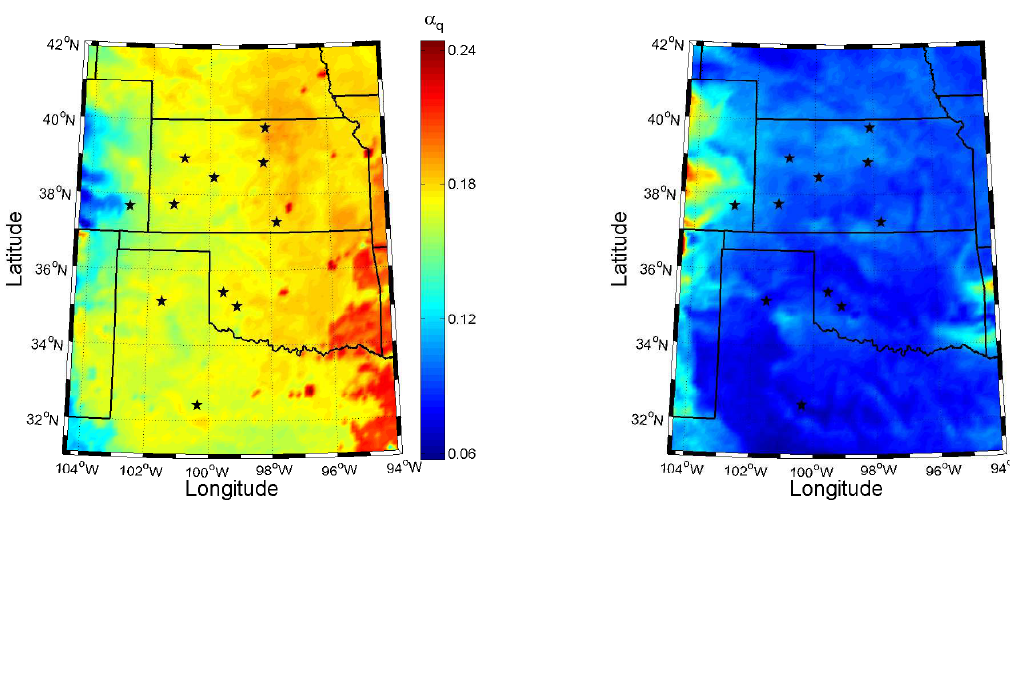
Figure 9. The WRF-NCAR model’s terrain elevation (left panel) above mean sea level (m) and USGS land use (LU) categories that the WRF model assigns to the grid points (right panel). The LU indices are [39]: 1 – urban, 2 – dryland crop and pasture, 3 – irrigated crop and pasture, 5 – cropland/grass mosaic, 6 – cropland/wood mosaic, 7 – grassland, 8 – shrubland, 10 – savanna, 11 – deciduous broadleaf, 14 – evergreen needle-leat, 15 – mixed forest, and 16 – water